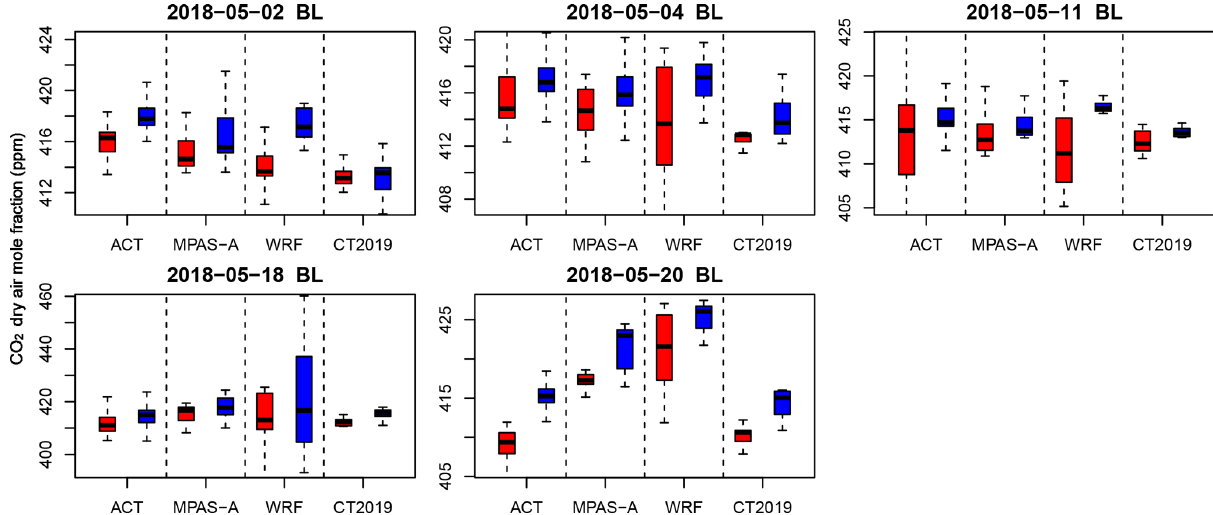
Figure 10. Box plots comparing mean boundary layer (BL) CO 2 mole fraction of the warm sector (red color) and cold sector (blue color) for 15 frontal crossing flights from summer 2016 and winter 2017 ACT campaign seasons. The flight date of each plot is labeled in its title. Data are combined when both aircraft (C130 and B200) took measurements for a given day. Each subfigure is separated into four groups by the dotted lines: the first group is from ACT observations, the second is from the MPAS-A simulation, the third is from the WRF-Chem simulation, and the last is from CT2019. In each box plot, the bottom and top edges of the box represent the first (Q1) and third (Q3) quartiles, the horizontal line represents the median, the ends of the whiskers represent Q1 − 1.5 × IQR (interquartile range) and Q3 + 1.5 × IQR, respectively, where IQR = Q3 − Q1. Table 11. Comparison of mean CO 2 dry-air mole fraction (ppm) in the boundary layer between the warm and the cold sectors. The table includes 10 frontal crossing flights from the summer 2016 season and 5 from the winter 2017 season. The column labeled “diff” is the mean value of the warm sector minus that of the cold